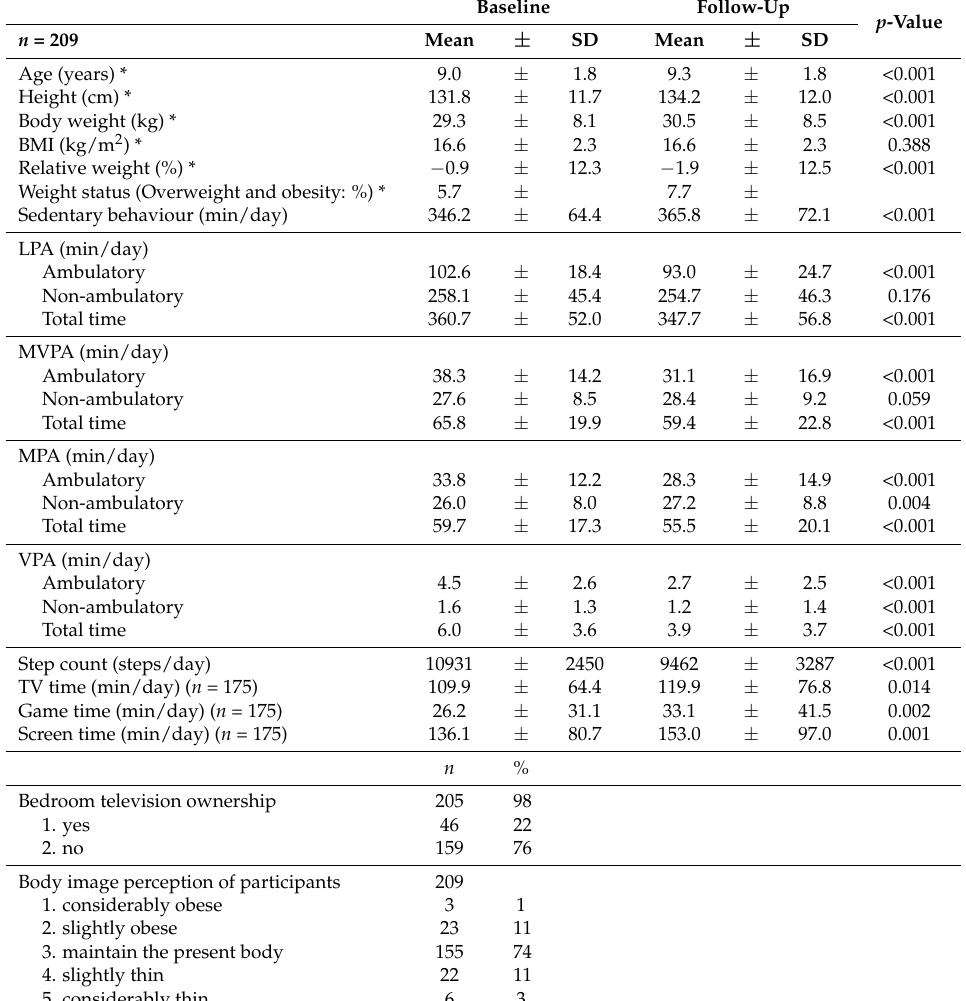
Table 1. Physical characteristics, habitual sedentary behaviour and physical activity, screen time, bedroom television ownership and body image for